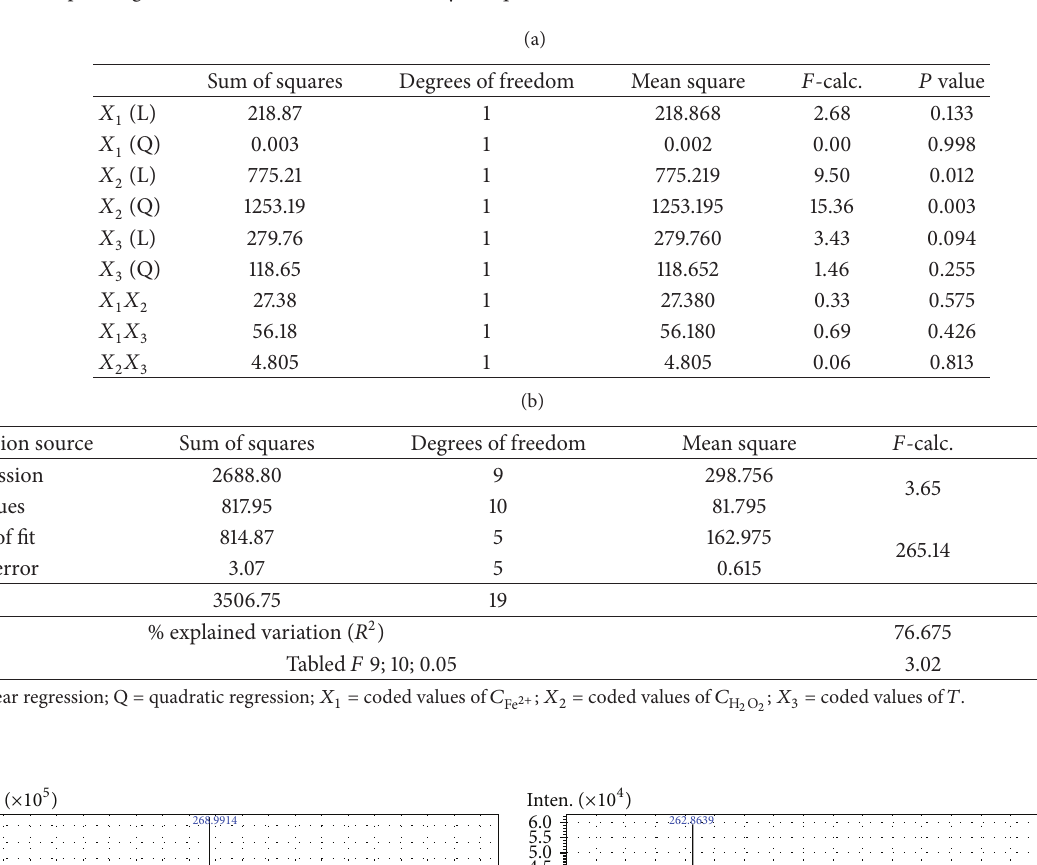
= 25 mg/L, 𝐶 = 611 mg/L, and 𝑇 = 35.0 ∘ C. A, B, D, and E: Fe 2+ H 2 O 2